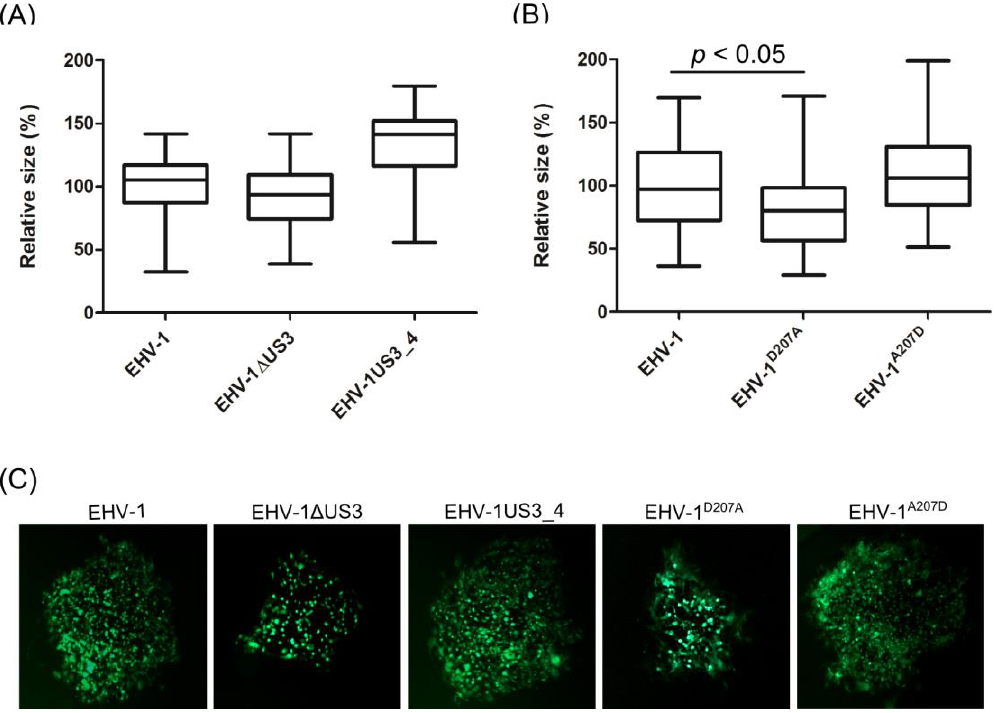
Figure 3. Determination of cell-to-cell spread by plaque size assay. ED cells were infected with EHV-1 ∆ US3 ( A ) or EHV-1 D207A ( B ) viruses at a multiplicity of infection (MOI) of 0.001. After 72 h, 50 plaques were measured for each virus. The central line in the box plot indicates the median of the data, while the edges of the box indicate the 25 th and 75 th percentiles. Extending from the box are whiskers, the top whisker expands to the 95 th percentile and the bottom whisker to the 5 th percentile. The plaque diameter of parental viruses was set to 100%. A significant reduction (one-way ANOVA; p < 0.05) of plaque size for EHV-1 D207A was seen when compared to parental, mutant, recombinant or revertant viruses. ( C ) plaques produced by different green fluorescent protein (GFP)-expressing viruses. Pictures were taken using a Zeiss Axiovert fluorescence microscope.